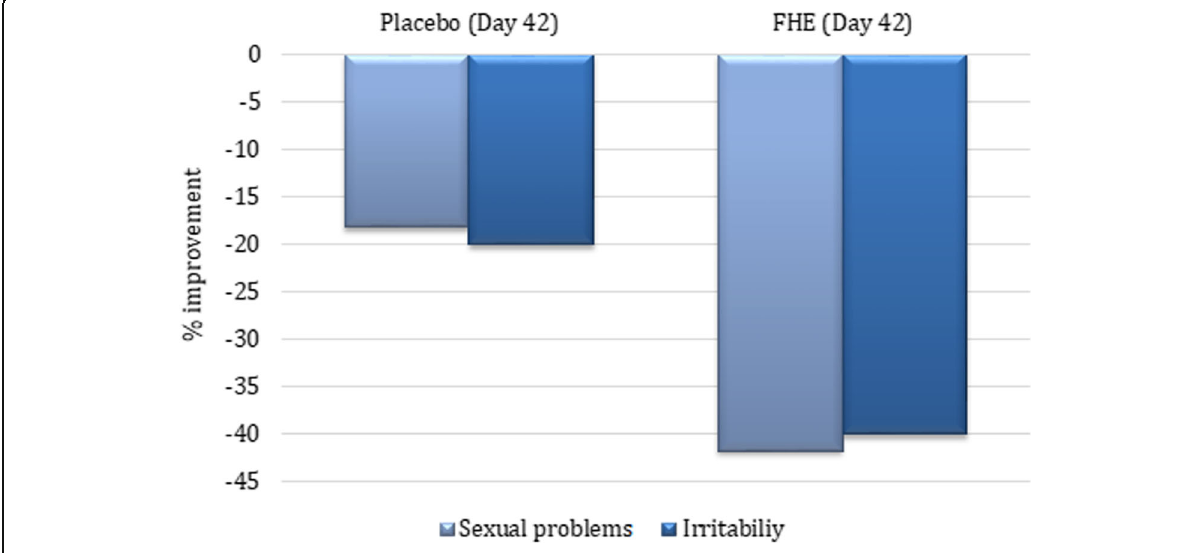
Fig. 3 Percentage improvement in sexual problems and